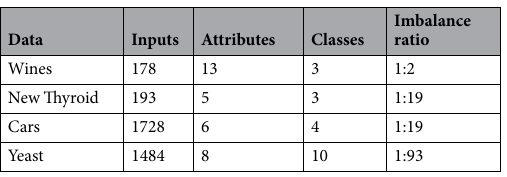
Table 1. Description of the benchmark data sets used for the validation of the model.